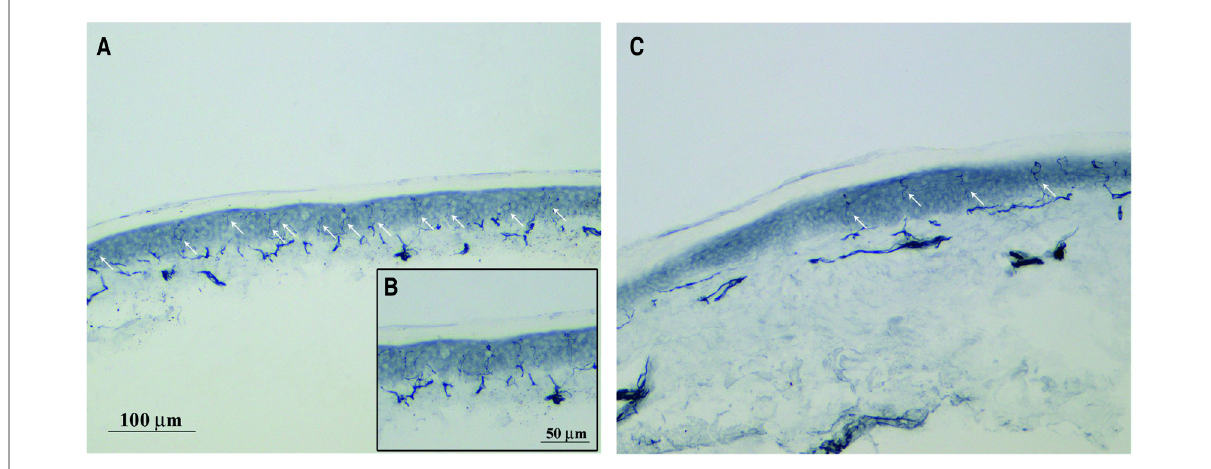
FIGURE 1 PGP 9.5 immunohistochemical staining free intraepidermal nerve fi bers endings. Representative images of skin biopsy from a control ( A ), higher magni fi cation in ( B ) and PTX-treated rats ( C ) after 4 weeks of treatment (bar A and C=100 μ m, bar B=50 μ m). PGP9.5 immunohistochemical staining was performed to measure the intraepidermal nerve fi bers (IENF) density using a previously published protocol (26). Brie fl y, glabrous skin from the plantar hindpaw were fi xed, cryoprotected and serially cut in 20 μ m-thick sections. Sections were immunostained with rabbit polyclonal anti-protein gene product 9.5 (PGP 9.5; ProteinTech, Manchester, United Kingdom) using a free- fl oating protocol. The total number of PGP 9.5- positive IENF crossing the dermal-epidermal junction was counted under a light microscope at 40× magni fi cation and then the IENF density was expressed as number IENF/length of epidermis